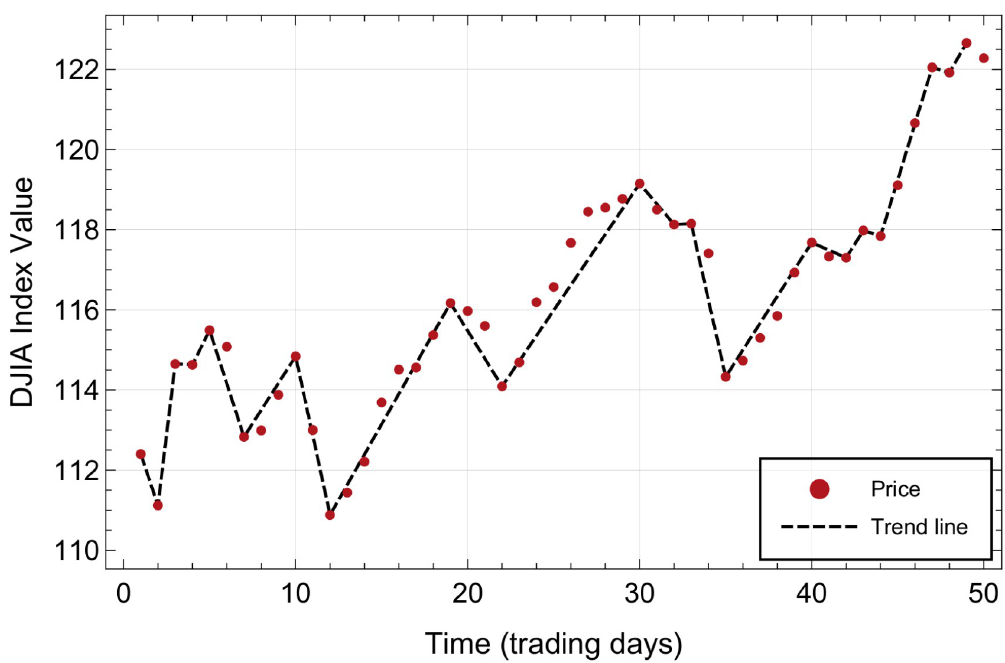
Fig 1. Elementary trends on the time series for the prices of the DJIA during the period from Oct/30/1978 to Jan/09/ 1979. The dashed line segments join the starting and ending points of each elementary trend.